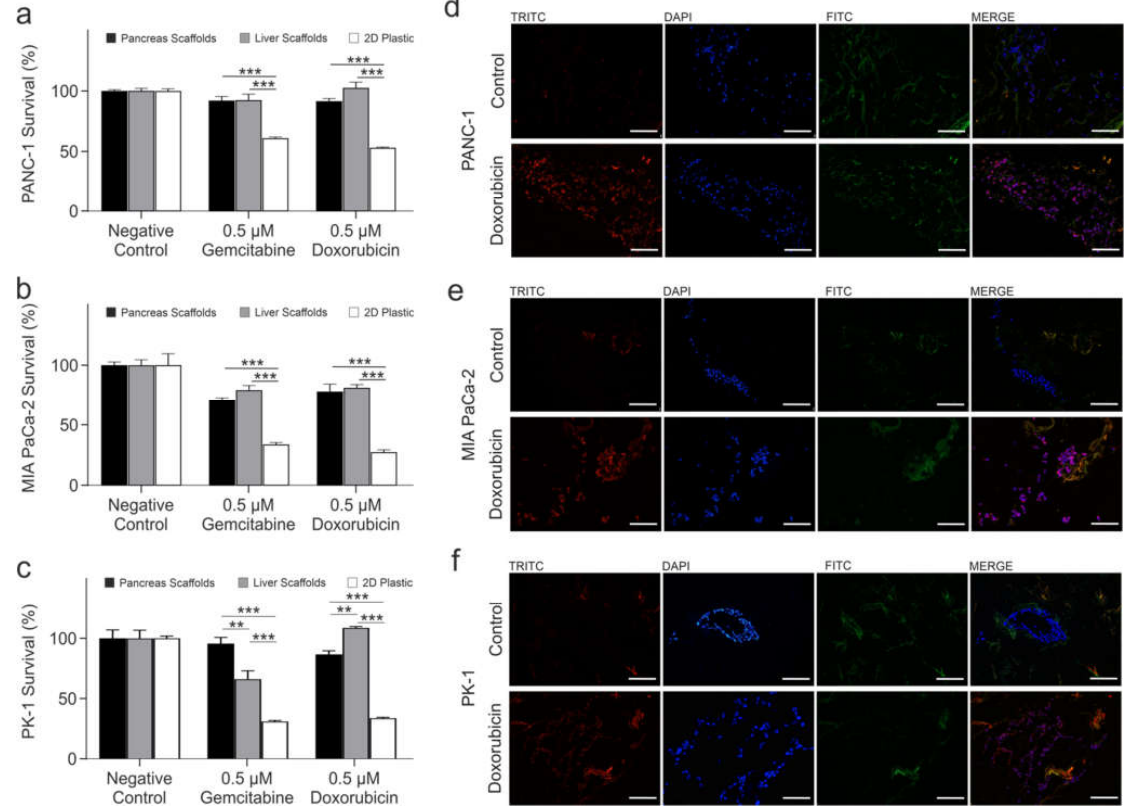
Figure 4. Comparison of PDAC cell response to chemotherapeutic treatments in 3D scaffolds vs. 2D plastic. Alamar blue viability assay of ( a ) PANC-1, ( b ) MIA PaCa-2 and ( c ) PK-1 cells cultured on pancreas scaffolds (black bars), liver scaffolds (grey bars) and 2D plastic, treated with 0.5 µ M gemcitabine and 0.5 µ M doxorubicin. Validation of doxorubicin uptake by PDAC cells. Fluorescent imaging of ( d ) PANC-1, ( e ) MIA PaCa-2 and ( f ) PK-1 cultured on pancreas scaffolds that were not treated (control; top panel) did not present any fluorescence in the doxorubicin channel (TRITC; red) but presented a positive fluorescence for nuclei (DAPI; blue) and collagens (FITC; green). All doxorubicin-treated samples (bottom panel) presented a fluorescence on the doxorubicin channel (TRIRC; red), nucleus channel (DAPI, blue) and collagen channel (FITC, green). When the three channels were merged, it was evident that doxorubicin had reached the nucleus (purple). All the images were obtained using a 20x objective. Scale bars are representative of 100 µ m. Data are expressed as mean ± s.d. ** p < 0.001 and *** p < 0.0001 ( n = 8 scaffolds per condition for ( a – c )) and ( n = 3 scaffolds for ( d – f